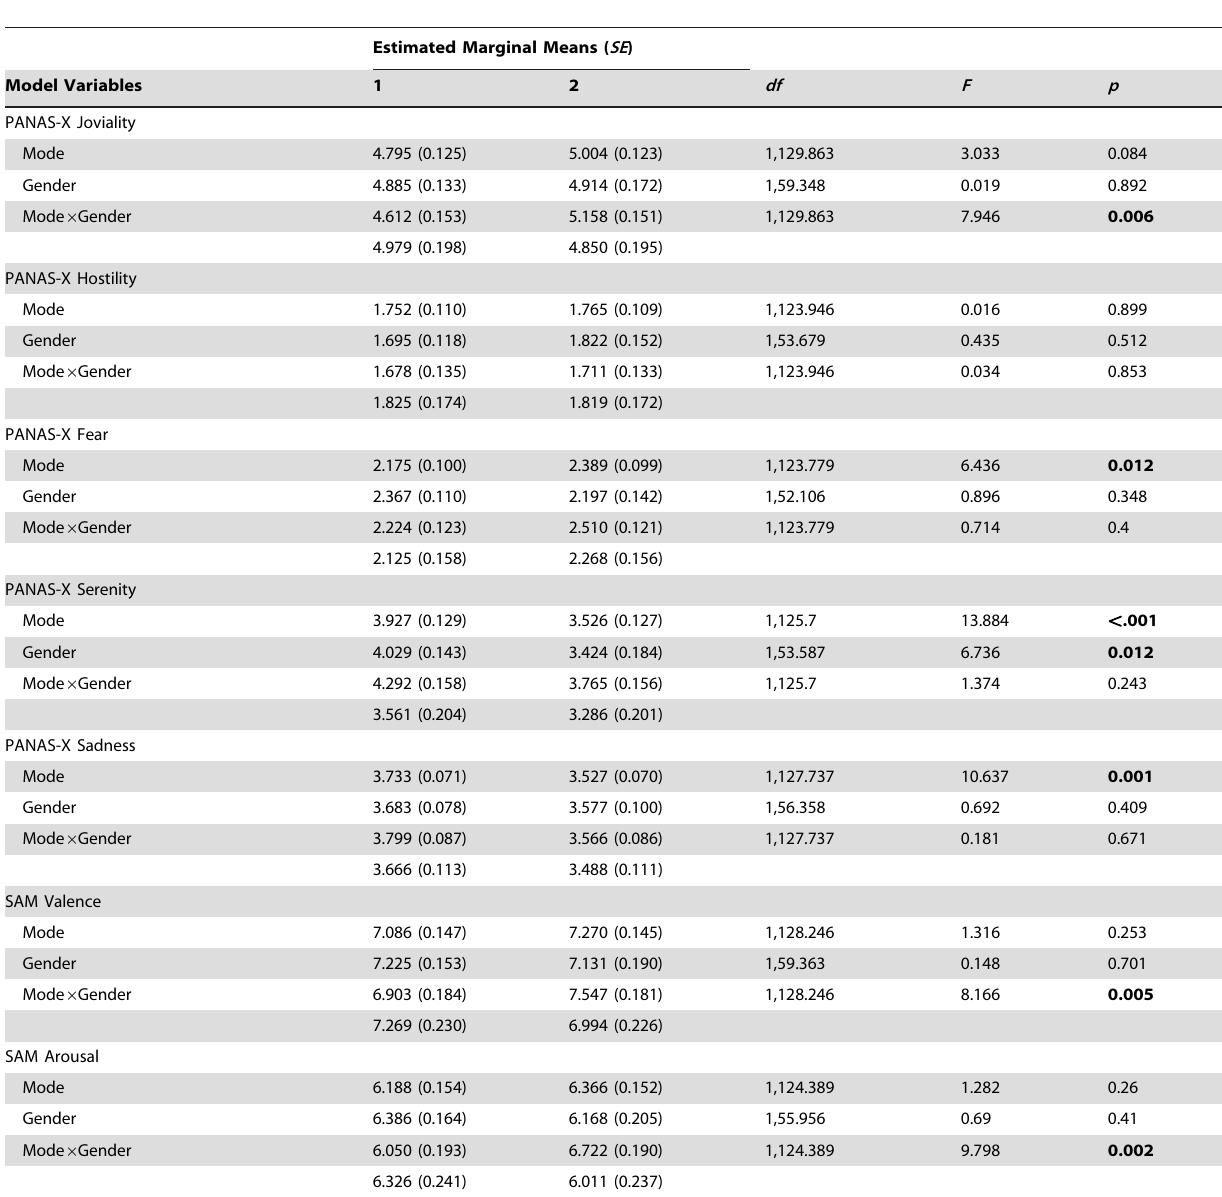
Table 2. Experiment 1 Linear Mixed Models for Self-Report Dependent Variables.